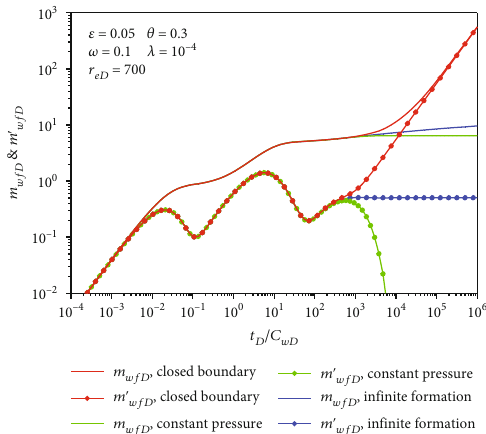
Figure 9: The in fl uence of outer boundary conditions. curve going upward. For constant boundary, the pseudo- pressure remains constant, which makes the pseudopressure curve becomes horizontal line and the derivative curve drops to 0. For in fi nite formation, the pseudopressure curve rises slowly and the derivative curve becomes horizontal line.